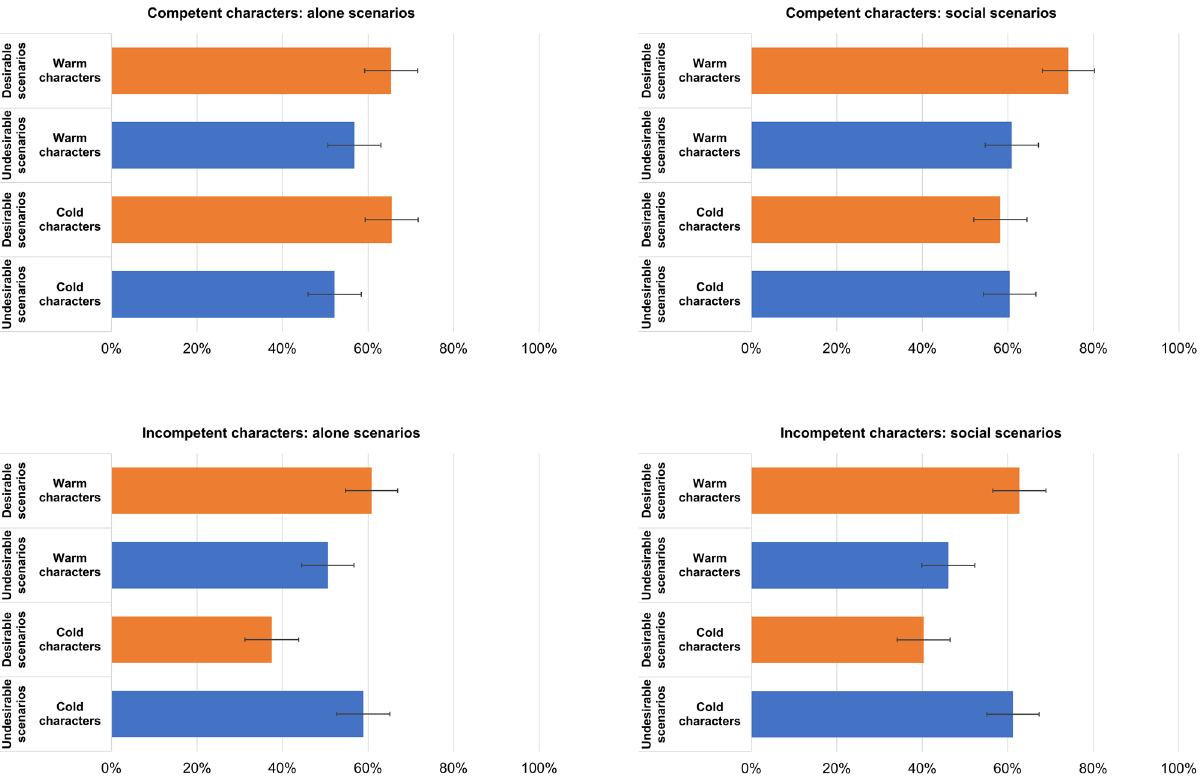
Figure 3. Four-way interaction between warmth, competence, valence and sociality. The bars represent 95% confidence